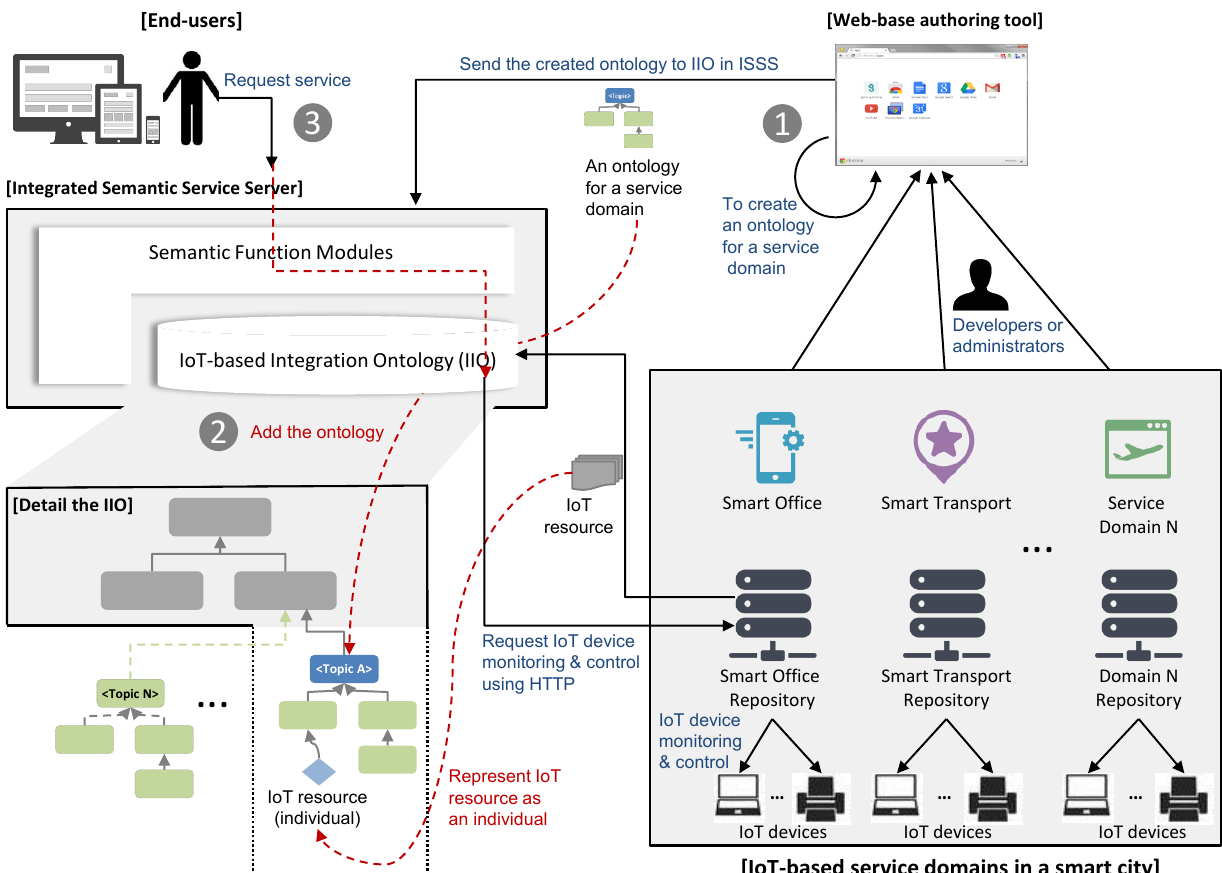
Figure 3. The overview of the integrated semantic service server